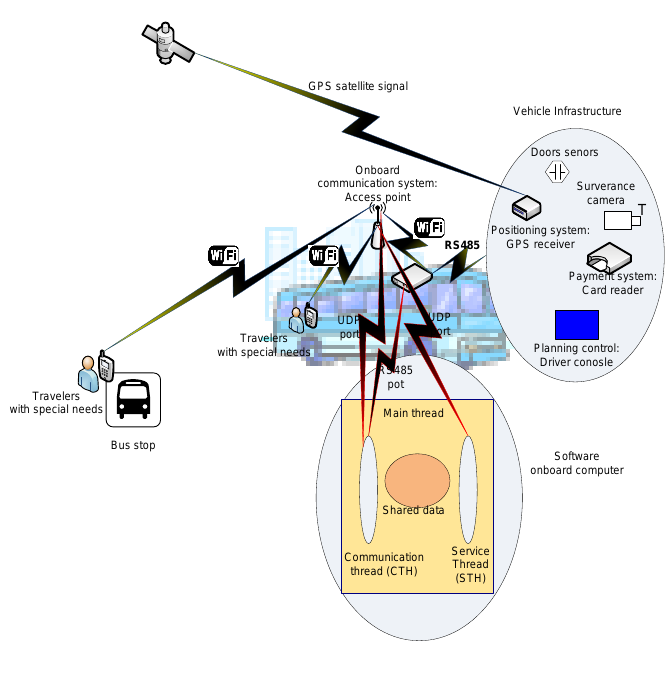
Figure 3. On-board system. Table 2. Data frame